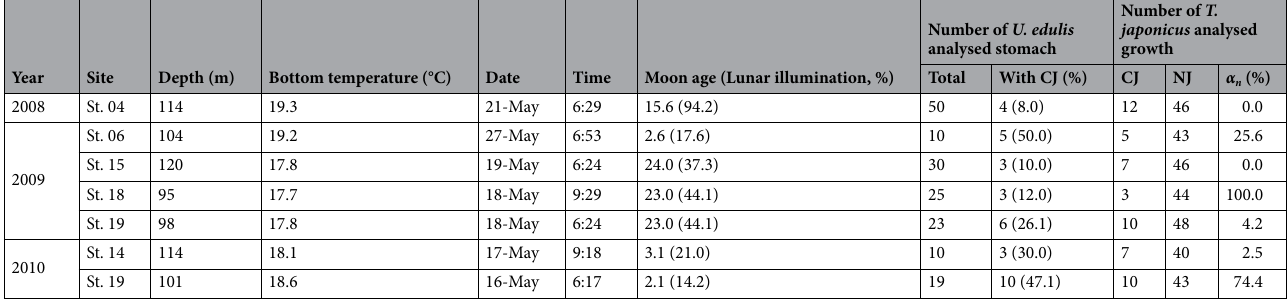
Table 1. Number of individuals of Uroteuthis edulis used for stomach content analysis and those of Trachurus japonicus used for growth comparison between the consumed juveniles (CJ) and the netted juveniles (NJ) with proportions of the unpalatable individuals in the netted juveniles ( α n ) in the East China